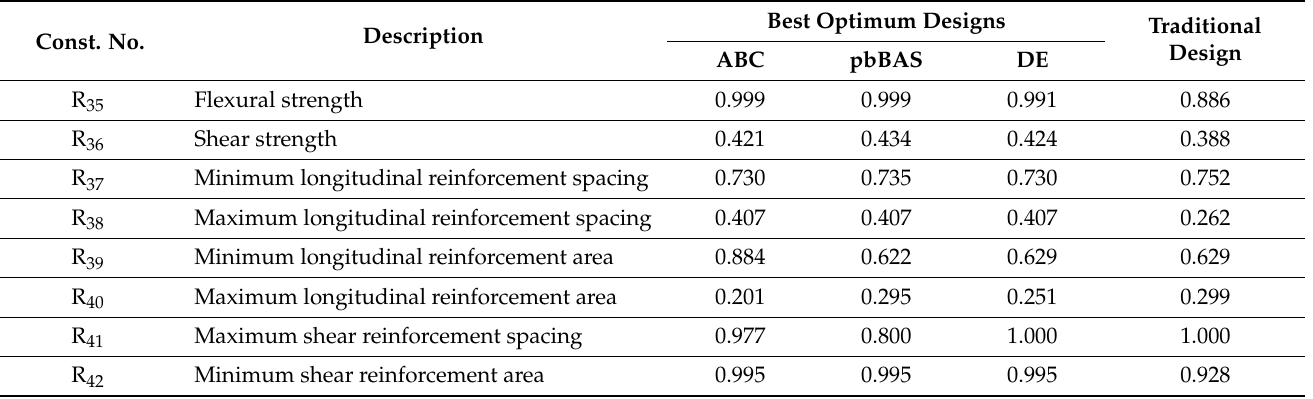
Table 20. Column’s constraints the maximum demand capacity ratio in the optimum designs achieved by each metaheuristic algorithm for the V-type folded plate roof building.